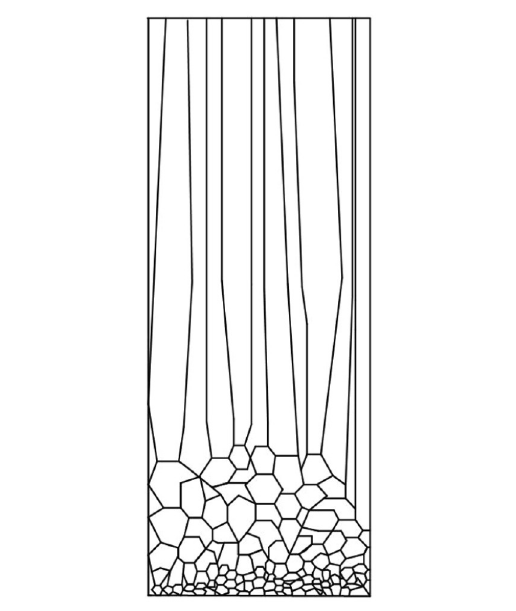
Figure 5. Schematic diagram of epitaxial grain growth of additive deposition of Ti6Al4V sample.